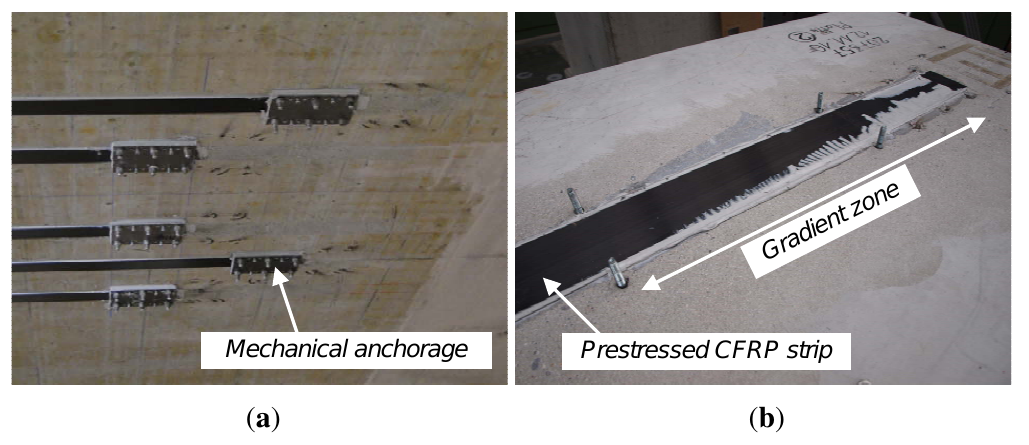
Figure 1. ( a ) Mechanical anchorage and ( b ) gradient anchorage for prestressed carbon fiber reinforced polymer (CFRP)